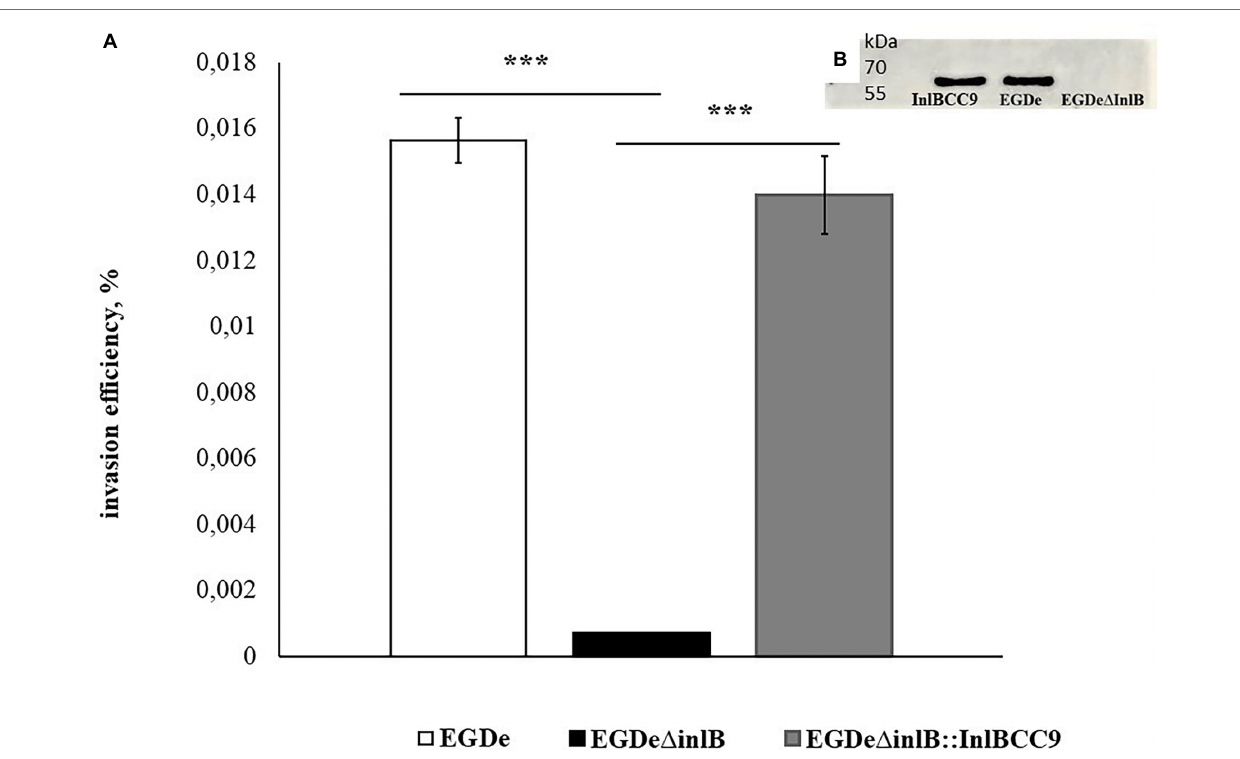
FIGURE 7 | InlB is required for invasion into ruminant cells. (A) Invasion efficiency test in sheep kidney cells by the wild-type strain EGDe, its derivative EGDe Δ inlB lacking the inlB gene and the complemented strain EGDe Δ inlB::InlBCC9. The mean ± SD from three independent experiments is shown. The statistical significance of competition experiments relative to a corresponding positive control is shown (*** p < 0.001). (B) Immunoblotting analysis of membrane-bound proteins of the EGDe Δ inlB::InlBCC9, EGDe, and EGDe Δ inlB strains. InlB was visualized with polyclonal primary anti-InlB antibodies were obtained as described earlier (Povolyaeva et al., 2020). GAPDH of Listeria monocytogenes was used as a